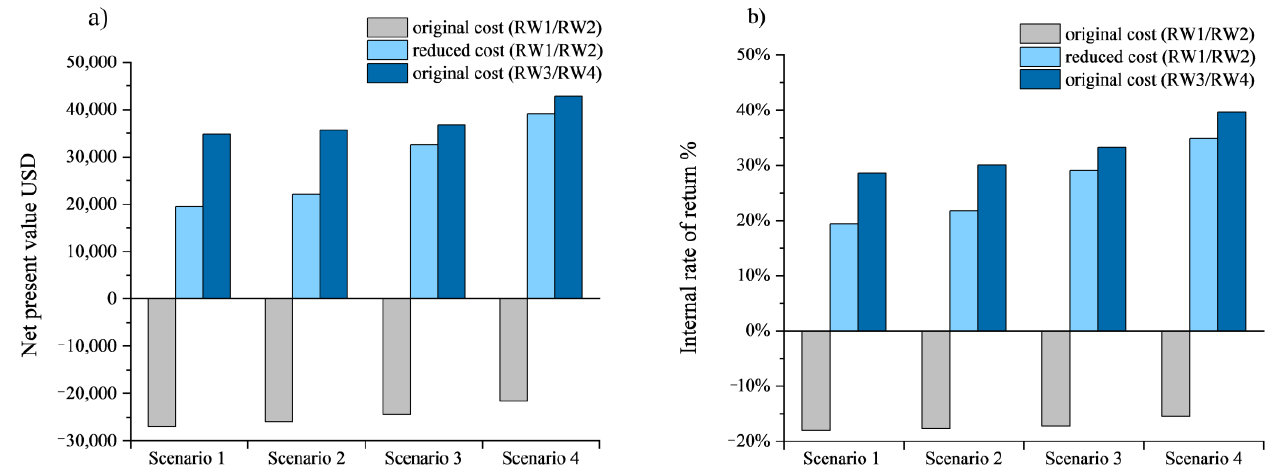
Figure 5. Effect of reducing the IPRS growout raceway construction investment cost by 66% on ( a ) net present value (USD) and ( b ) internal rate of return (%). A discount rate of 5% was used. Scenario 1 includes pond construction, all machinery/equipment cost, and all land costs. Scenario 2 includes pond construction, all machinery/equipment cost, and no land cost. Scenario 3 includes pond construction, 80% less machinery/equipment cost, and no land cost. Scenario 4 represents an existing aquaculture operation that requires no pond construction, no machinery, and no land purchases, only some specialty IPRS items. Stocker unit were built from the less expensive materials, only growout units had their price